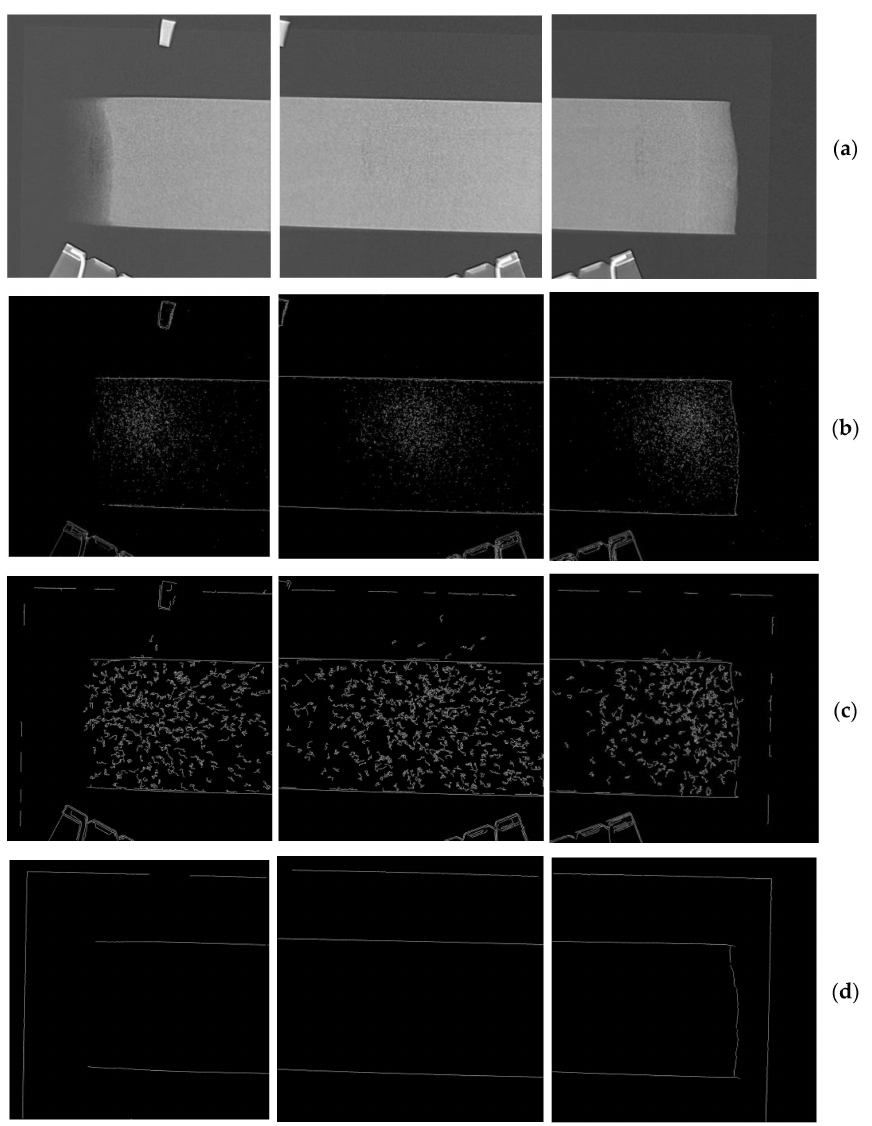
Figure 5. Edge extraction results of plate fuel neutron images: ( a ) Preprocessed images; ( b ) Sobel; ( c ) Canny; ( d ) proposed